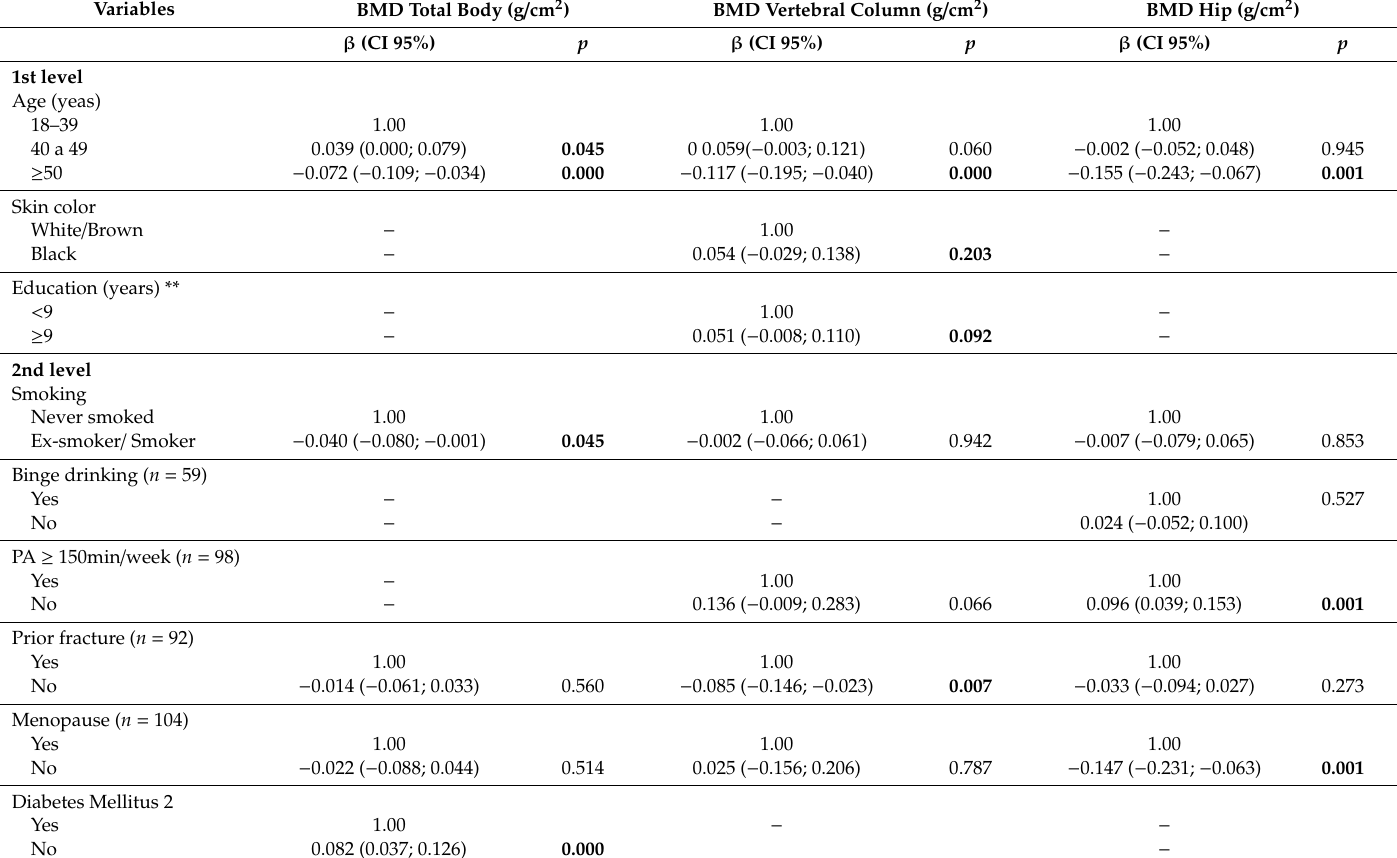
Table 5. Multiple hierarchical linear regression between total body, vertebral column and hip bone mineral density adjusted for sociodemographic variables, health conditions, nutritional indicators and biochemical tests in severely obese women, Goi â nia, DieTBra Trial, 2016 ( n =